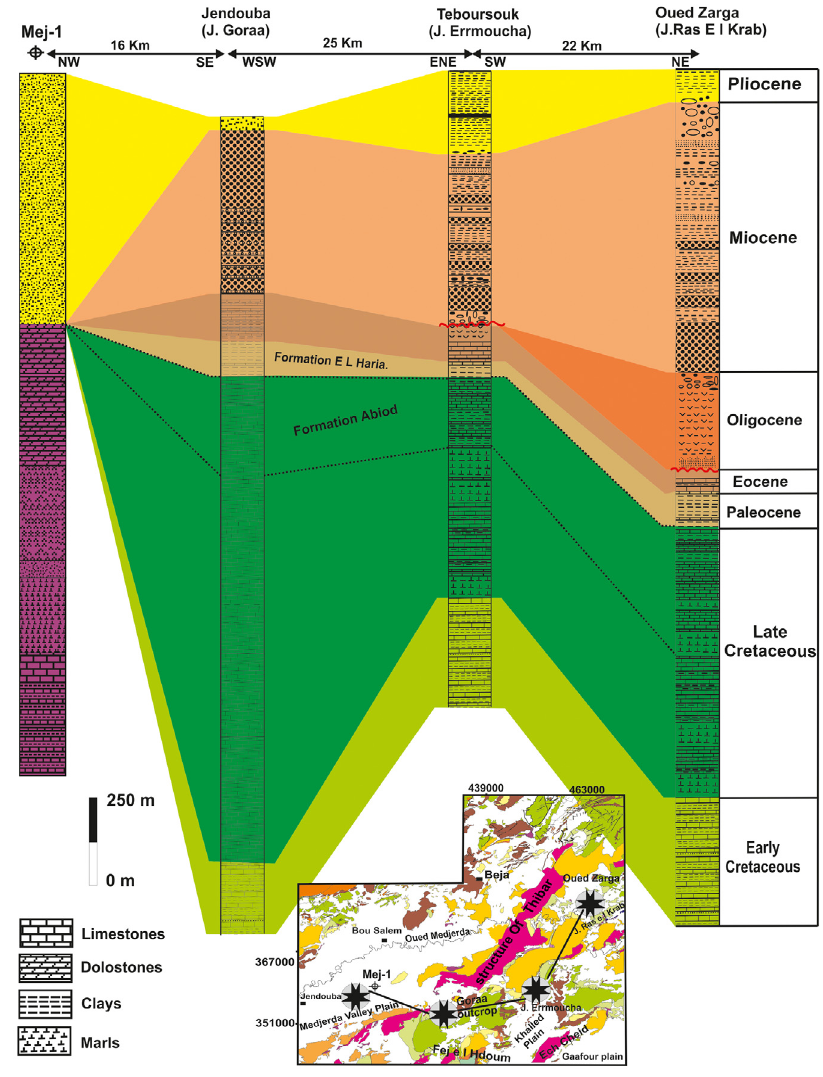
Figure 3. Lithostratigraphic correlation of the Mej-1 well and Mesozoic and Cenozoic outcropping strata, showing thickness and facies vari- ations and subsidence inversions related to tectonic deformations in the Thibar